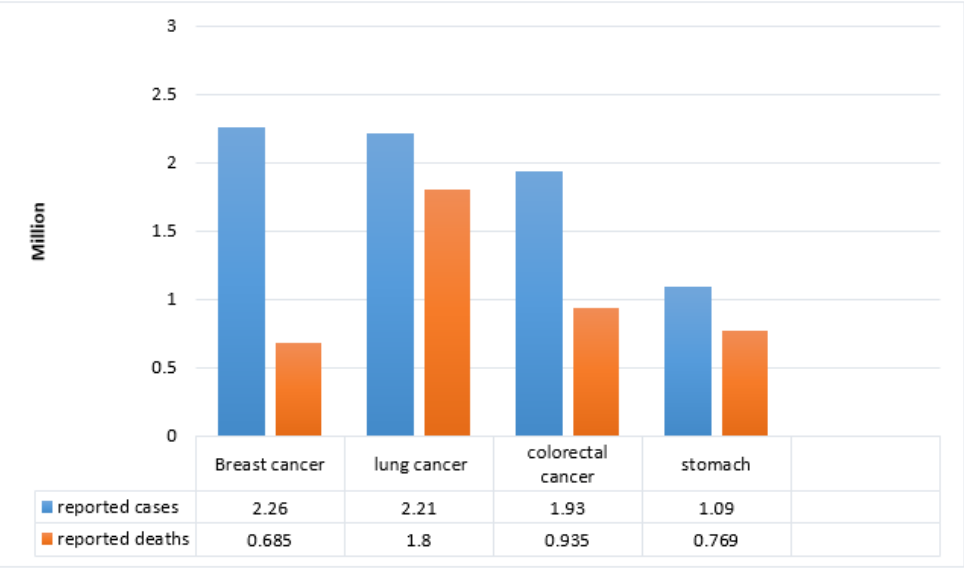
Figure 1. WHO statistics of reported cases and causalities worldwide by